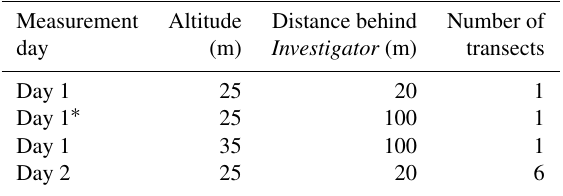
Table 1. Specifications of the transects considered for the data anal-